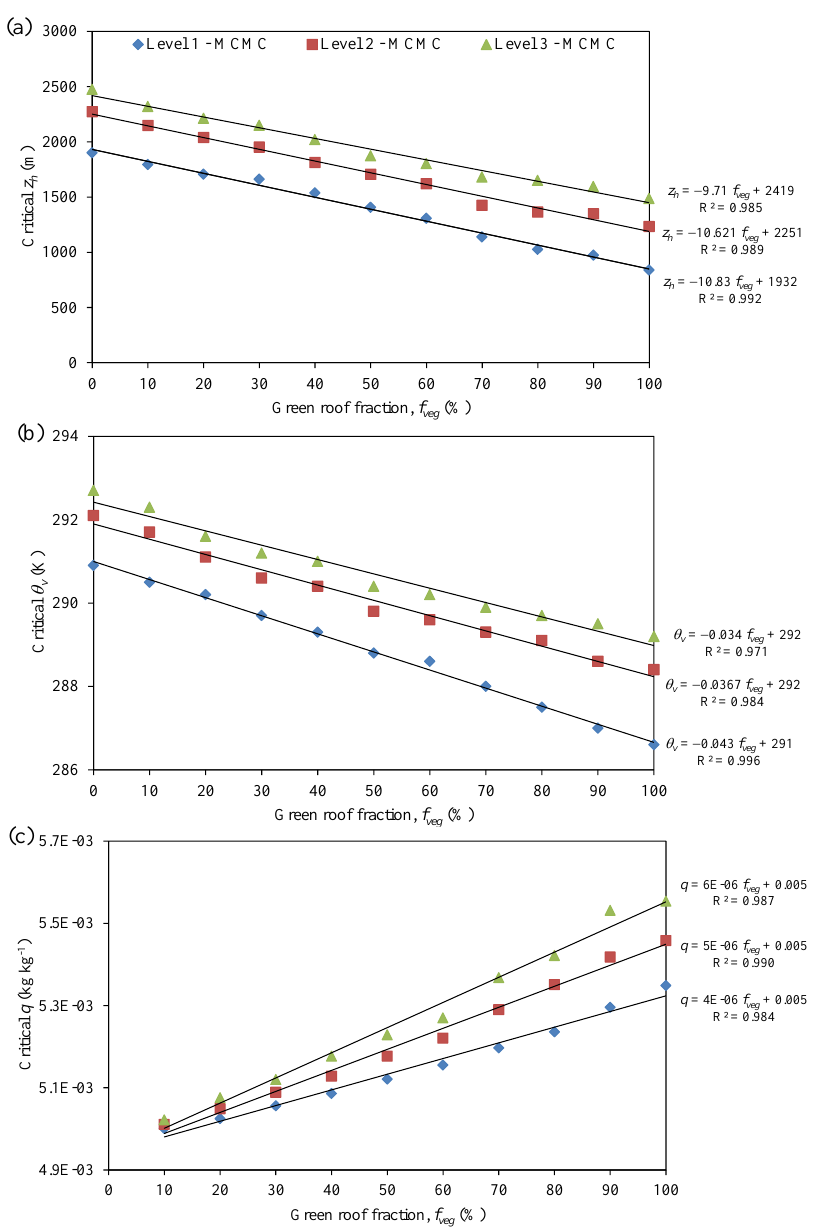
Figure 10. Threshold values at different conditional levels as functions of green roof fractions for critical (a) z h , (b) mixed layer θ v , and (c) mixed layer q . MCMC levels 1, 2, and 3 correspond to exceedance probabilities of 10 − 1 , 10 − 2 , and 10 − 3 , respectively.